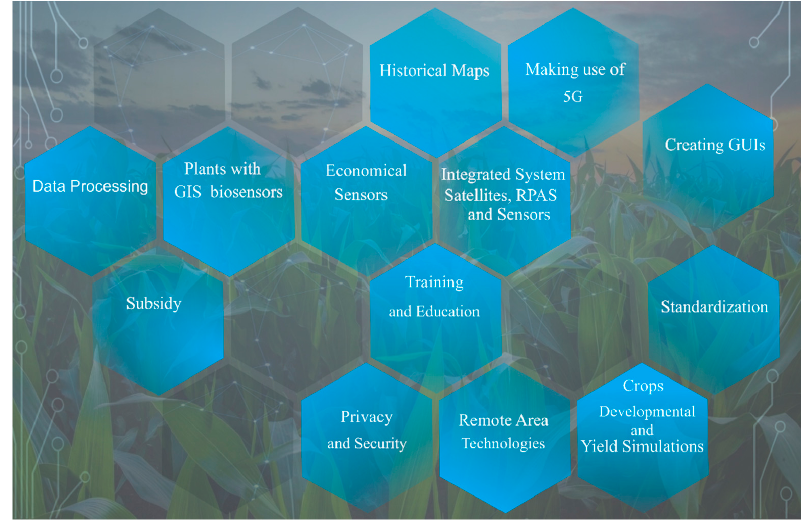
Figure 8. Future considerations of remote sensing (RS) technology applied to agriculture. Appl. Sci. 2021 , 11 , x FOR PEER REVIEW